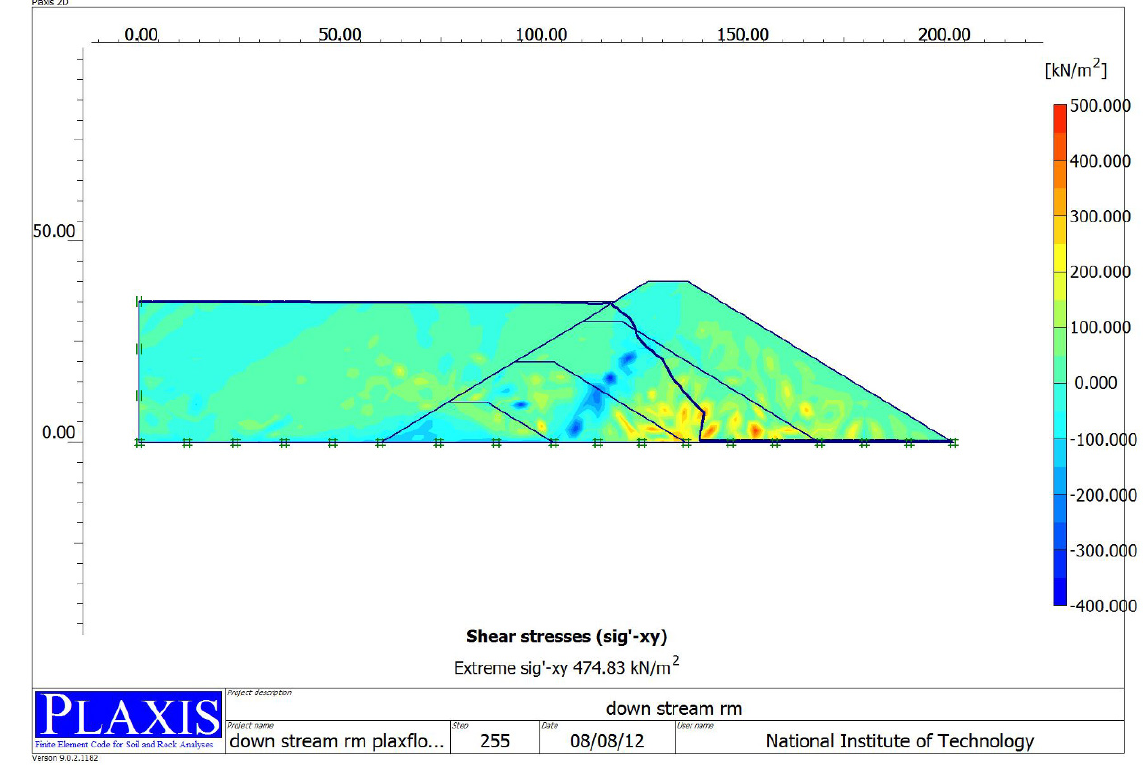
Figure 19. Effective stress diagram of downstream method dam in ZZ direction